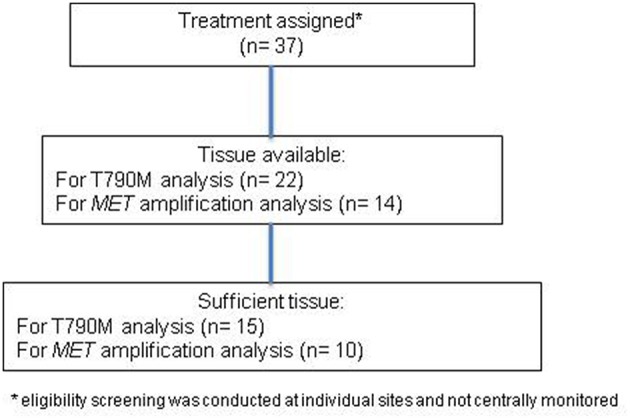
Consort diagram.